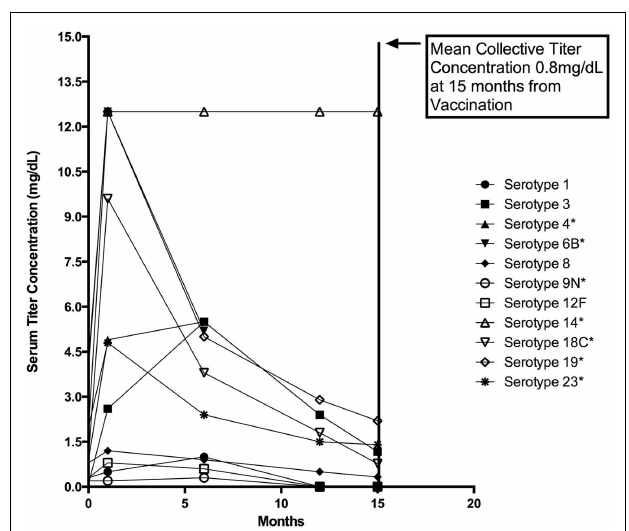
FIGURE 2 |Twenty-three valent pneumococcal vaccine response . Various pneumococcal vaccine serotype titers plotted together before vaccination and at represented intervals following vaccination with Pneumovax © at 4, 24, 52, and 60weeks.Vaccination was performed at 3years of age following a complete series of the pneumococcal conjugate (Prevnar 7©) vaccine at recommended ages (AAP schedule) (13). Note the serotypes indicated with an asterisk (*) indicate those included in the Prevnar 7 vaccine. For reference, minimally protective titer levels are accepted to be ≥ 1.3mg/dL [Bonilla et al. (14)]. Mean and one standard deviation are represented for each group. Mean serotype titers for